Question: Looking at the figure, what chart type is it?
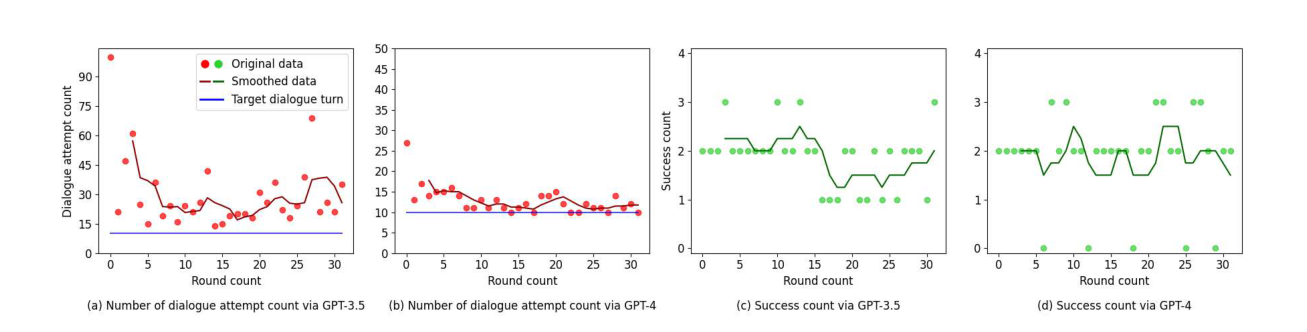
Answer: line